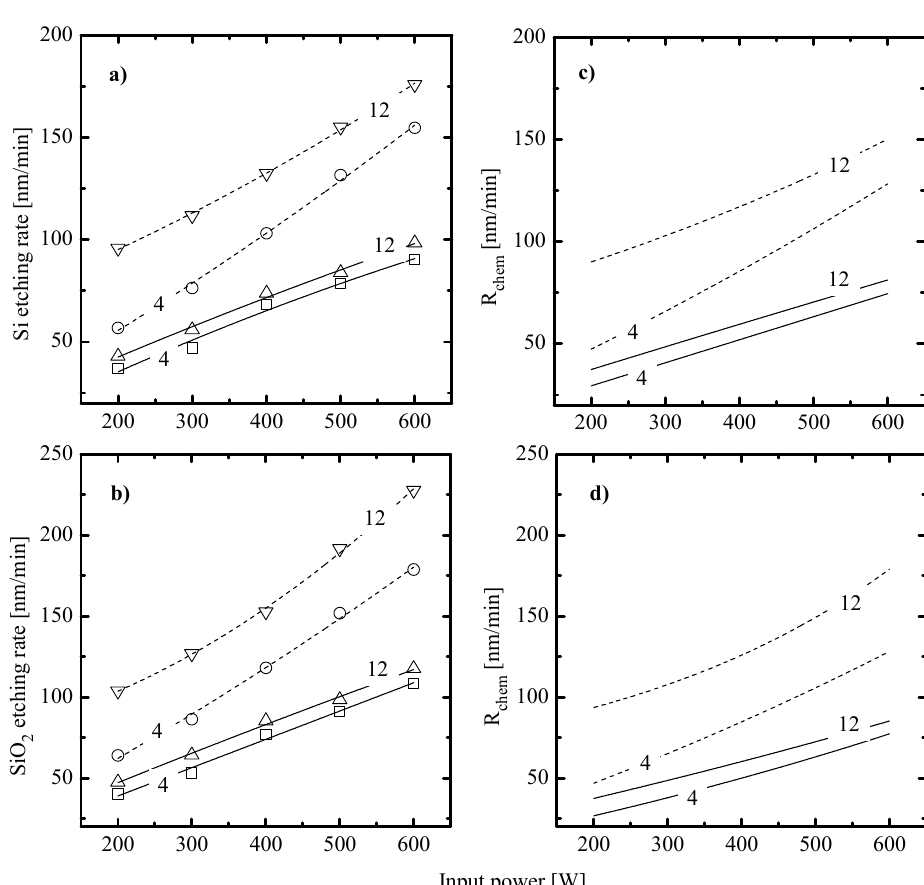
Figure 2. Measured etching rates ( a , b ) and calculated rates of ion-assisted chemical reaction ( c , d ) for Si and SiO 2 in 50% C 6 F 12 O + 50% Ar (solid lines) and 50% CF 4 + 50% Ar (dashed lines) plasmas. Numerical labels on curves mean the gas pressure in mTorr.